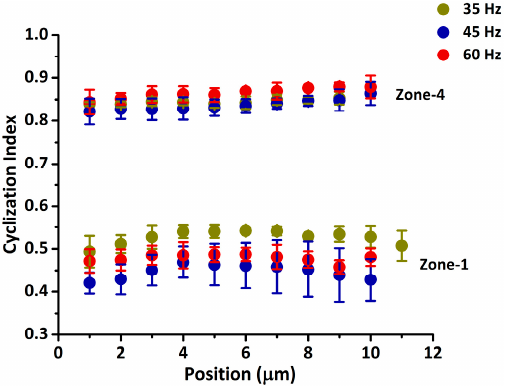
Figure 4. Cyclization index variation across the fiber cross-section in thermal stabilization.